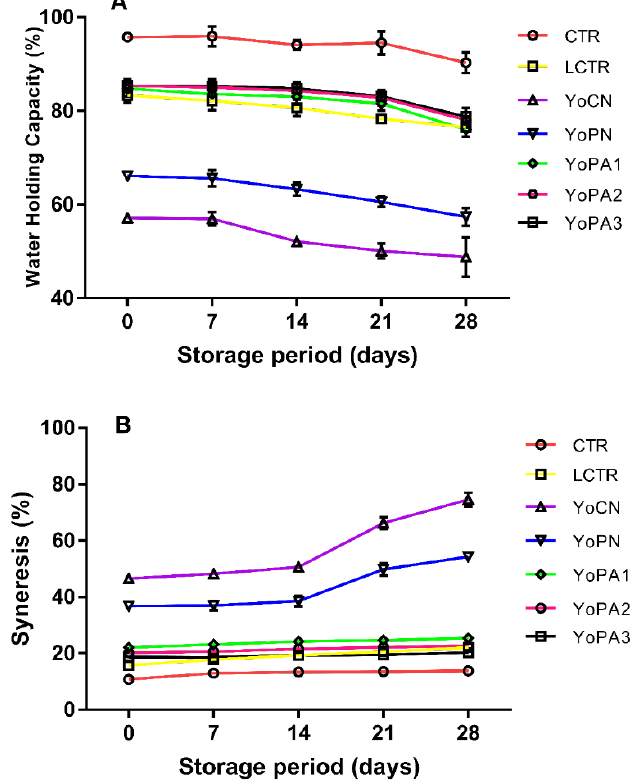
Figure 2. ( A , B ) Effect of refrigeration storage on water holding capacity and syneresis of yoghurt.